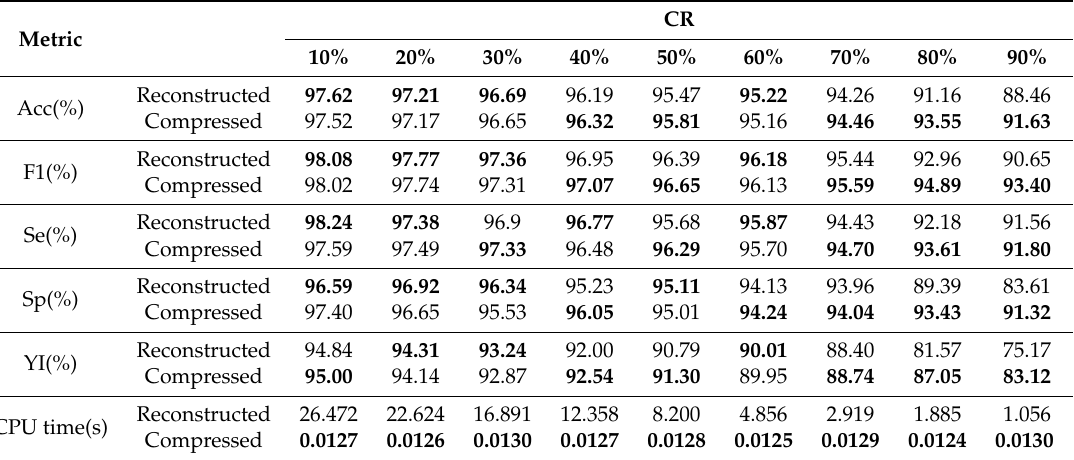
Table 2. Comparison of classification performance of atrial fibrillation detection from compressed ECG and reconstructed ECG, respectively. This table shows that the classification performance of proposed method is not inferior to the classification from reconstructed ECG, and real-time performance of the proposed method is much better. Bold numbers represent the best results between the compared